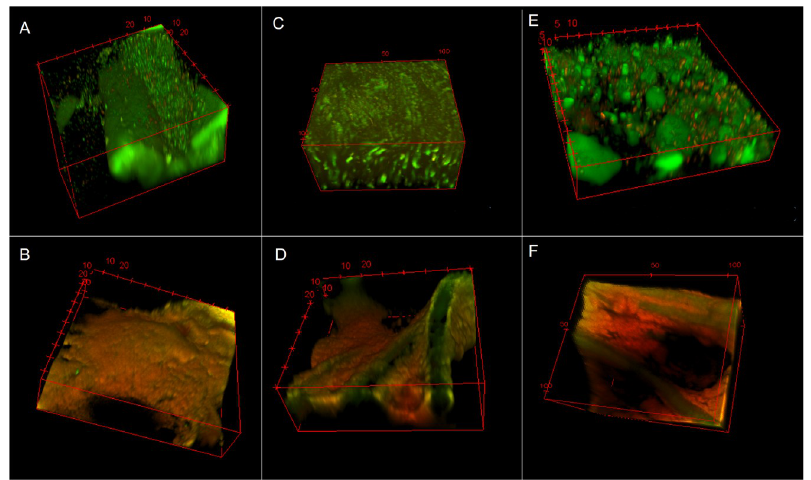
Fig 6. 3D reconstructed CLSM images showing effect of representative topical agents against biofilms on the top (treated) side of cellulose discs. Images were collected with BacLight ™ Live/Dead stain. (A) MRSA biofilm treated with gentamicin (0.1%). The predominance of green (living cells) indicated there was limited antimicrobial activity against well-established biofilms. (B) MRSA biofilm treated with CZ-01179 (2%). The antimicrobial gel was highly effective at eradicating well-established biofilms. (C) P . aeruginosa biofilm treated with gentamicin (0.1%). The significant amount of living cells post treatment of gentamicin, demonstrates the limitations of the Hammond et al. method, as P . aeruginosa biofilms grown on collagen treated with gentamicin showed complete eradication (43). (D) P . aeruginosa biofilm treated with CZ-01179 (2%). The antibiofilm agent was able to disrupt the sheet-like structures of the biofilm. (E) Polymicrobial biofilms treated with silver sulfadiazine showed minimal efficacy. (F) Deep and widespread antimicrobial activity was observed within the matrix of the polymicrobial biofilm treated with CZ-01179 (2%) gel.